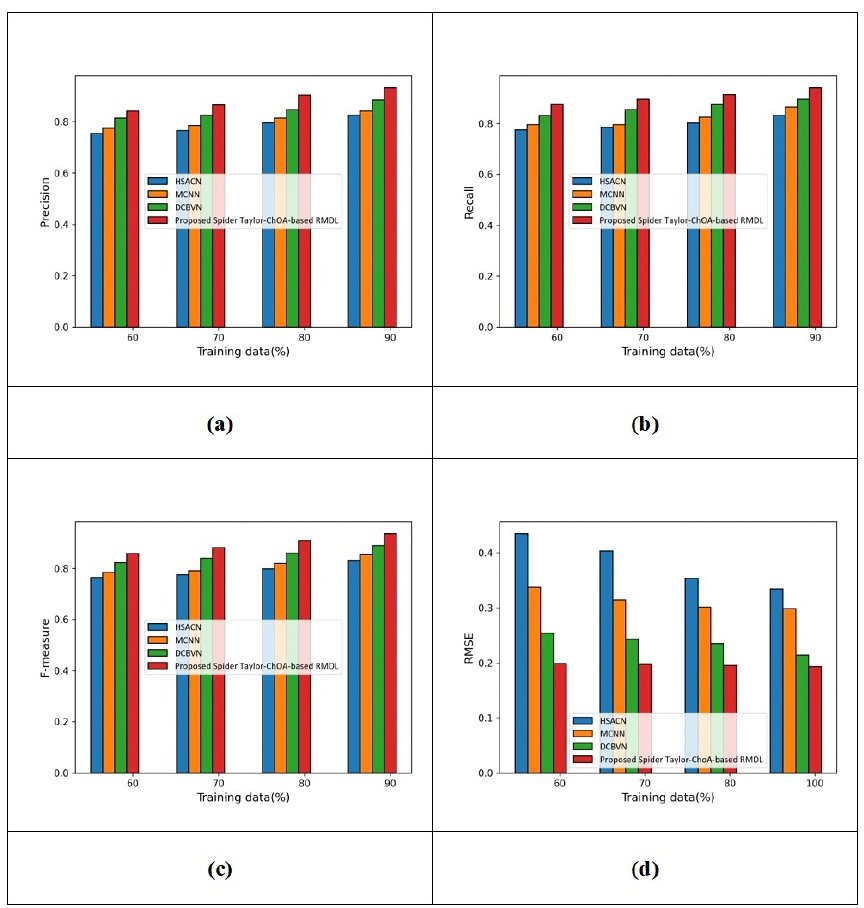
Figure 5. Results based on sentiment classification using Yelp 2013 datasets with ( a ) precision ( b ) recall ( c ) F-measure and ( d )